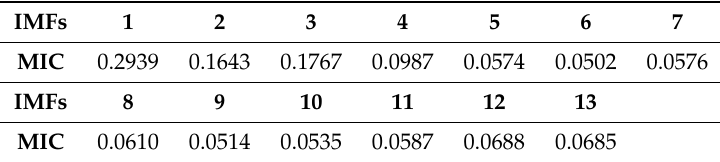
Table 1. The MIC values of